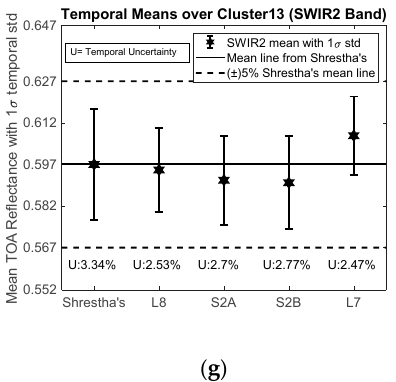
Figure 11. Validation of Cluster 13 mean temporal TOA reflectance values using OLI, Sentinel 2A/2B MSI, and ETM+ Sensors: ( a ) CA band; ( b ) Blue band; ( c ) Green band; ( d ) Red band; ( e ) NIR band; ( f ) SWIR1 band; ( g ) SWIR2 band.